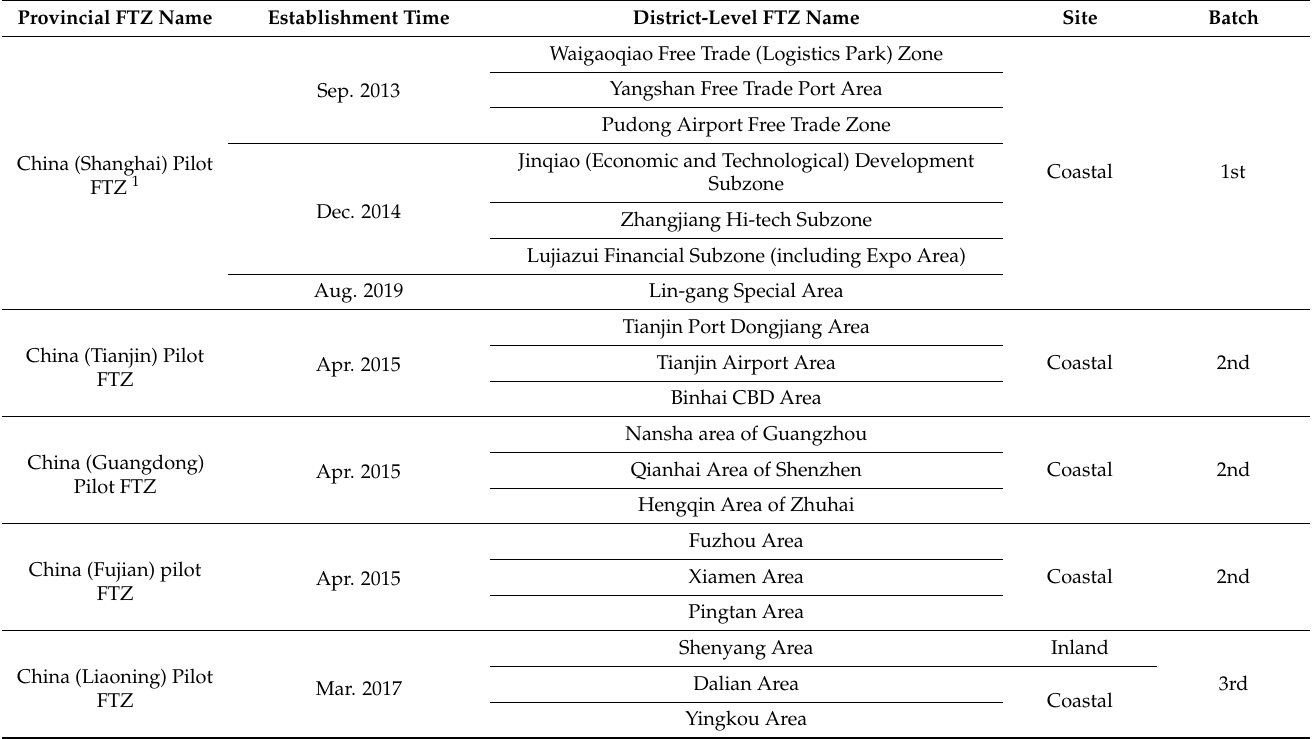
Table A1. The list view of all the free trade (pilot) zones (FTZ) in China (up to June